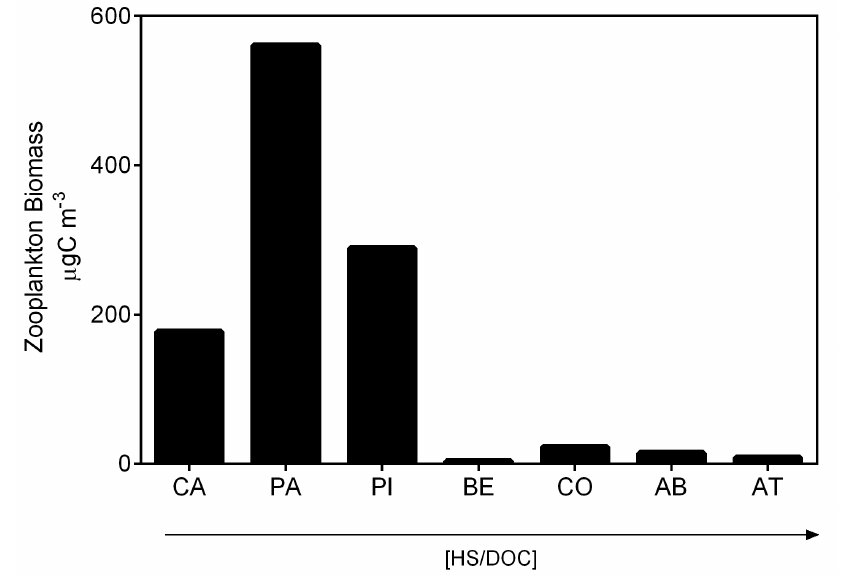
Figure 4. Biomass variation (μgC m -3 ) in all of the studied environments along an increasing humic substances concentration. CA= Cabiúnas; PA= Paulista; PI= Pitanga; BE= Bezerra; CO= Comprida; AB= Amarra-Boi; AT=